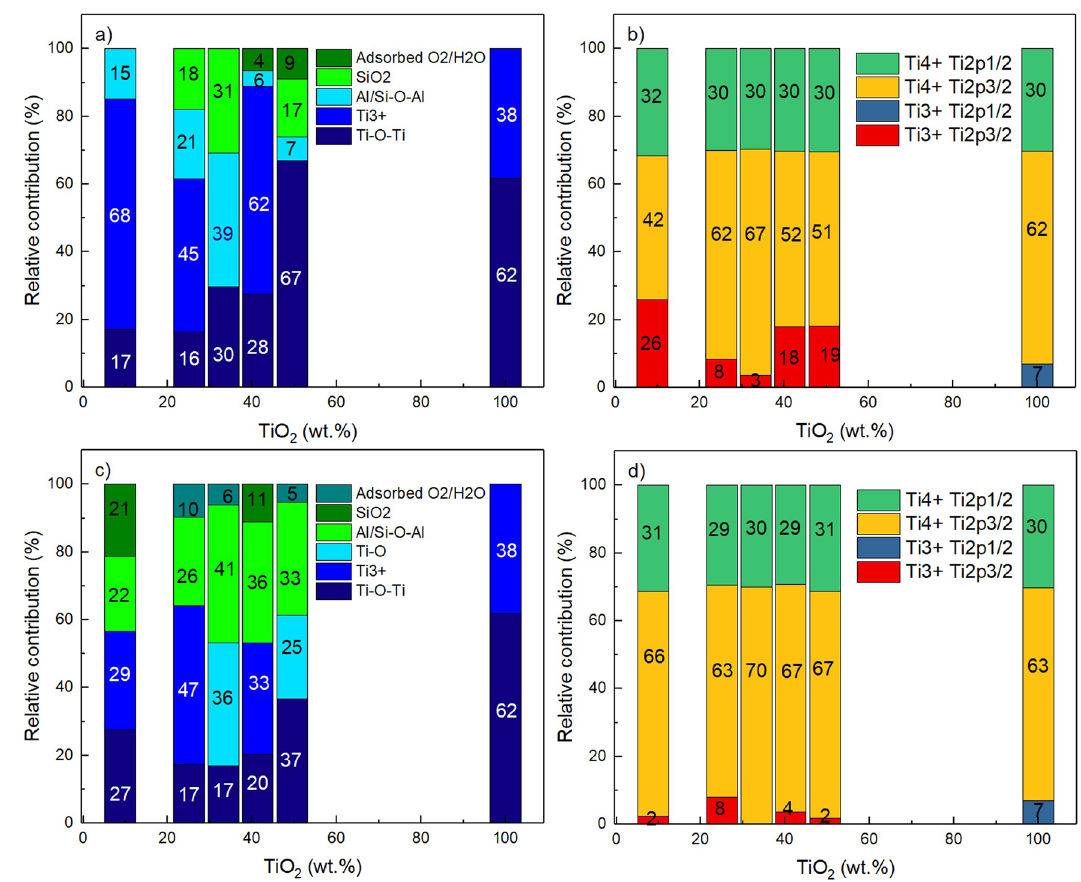
Figure 4. Relative contribution to the ( a ) O1s, ( b ) Ti2p peak for HYD-T; ( c ) O1s and ( d ) Ti2p peak for CAN-T hybrid